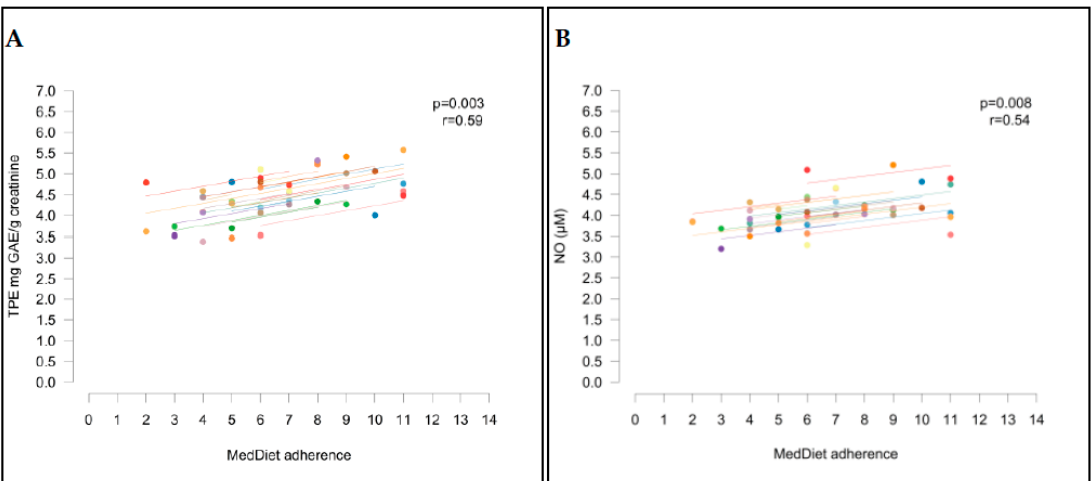
Figure 5. Correlation of Mediterranean diet adherence with TPE ( A ) and NO ( B ).